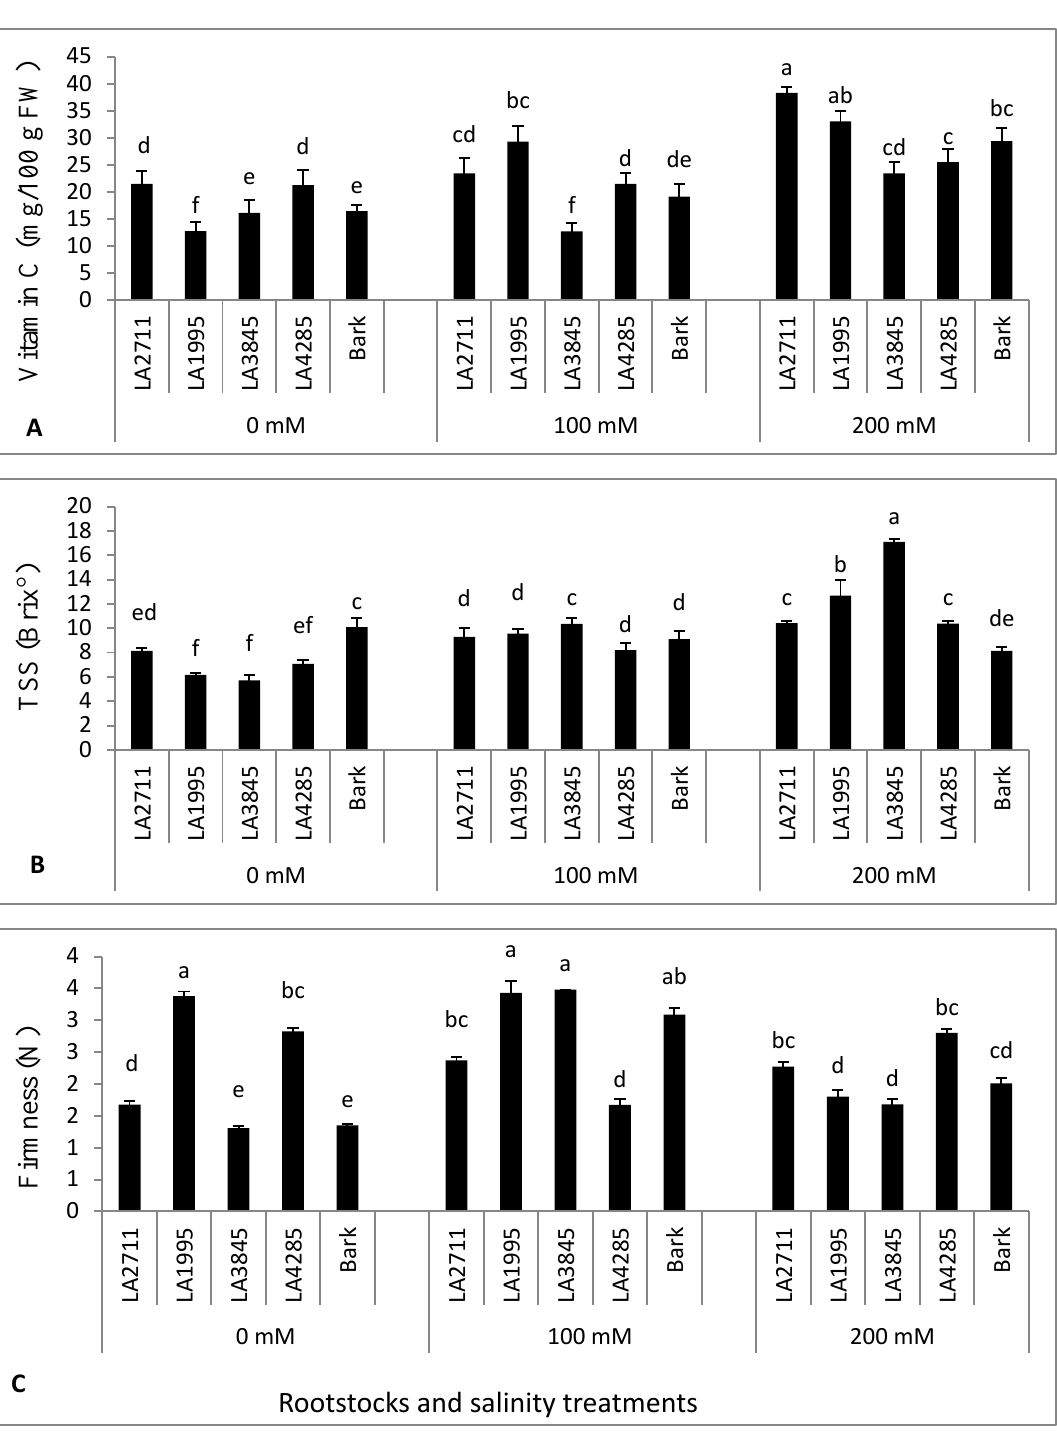
Figure 5. Effect of salinity levels × rootstocks interaction on ( A ) Vit. C, ( B ) TSS and ( C ) firmness. Vertical bars represent standard errors of means ( n = 3); in each bar, values followed by different letters differ significantly at p = 0.05 according to Tukey test.